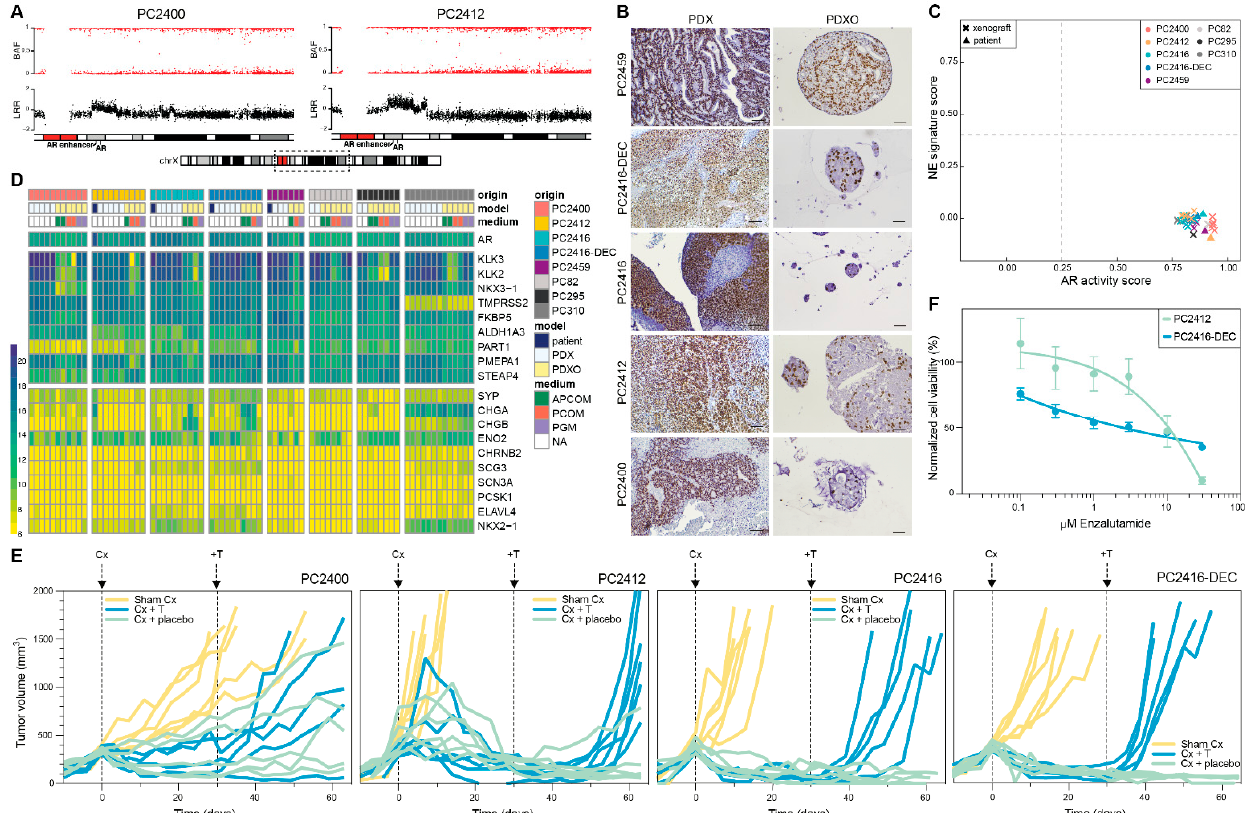
Figure 4. AR signaling status of CRPC PDXs and PDXOs. ( A ) B-allele frequency (BAF) and log R ratio (LRR) for the region of interest on chromosome Xq containing the AR gene and upstream AR enhancer, in PDXs PC2400 and PC2412. Dashed box on the chromosome X ideogram indicates the genomic region displayed above. ( B ) Nuclear AR staining in CRPC PDXs (left panel, scale bars 100 µm) and matching PDXOs (right panel, scale bars 50 µm). ( C ) Landscape plot of AR activity and NE signature scores in PDX ( n = 34) and patient ( n = 4) tumors. Thresholds separating samples with low versus high scores are marked with dashed lines. ( D ) Gene expression heatmap of a curated set of AR and NE marker genes shown across the entire dataset comprising original patient tumors (blue, n = 4), PDXs (white, n = 34) and PDXOs (yellow, n = 39) with different culture medium conditions (green: APCOM; red: PCOM; purple: PGM; white: not applicable (NA)). Expression levels are visualized as vst counts, based on RNA sequencing data. ( E ) Tumor growth responses after surgical castration (Cx) and testosterone supplementation (+T) in CRPC PDXs. When tumors passed a volume of 300 mm 3 (day 0), mice underwent either Cx (blue and green; PC2400 n = 10, PC2412 n = 12, PC2416 n = 11, PC2416-DEC n = 10) or sham Cx (yellow; n = 6 for each PDX). Thirty days after Cx, mice were implanted with a testosterone pellet (blue; PC2400 n = 5, PC2412 n = 6, PC2416 n = 5, PC2416-DEC n = 5) or placebo pellet (green; PC2400 n = 5, PC2412 n = 6, PC2416 n = 6, PC2416-DEC n = 5). ( F ) Dose-response curves of PC2412 and PC2416-DEC PDXOs exposed to enzalutamide treatment. Dots mark mean and error bars SEM of three and four individual experiments (six technical replicates per condition) for PC2412 and PC2416-DEC PDXOs, respectively. Cell viability was normalized to vehicle (DMSO) controls.